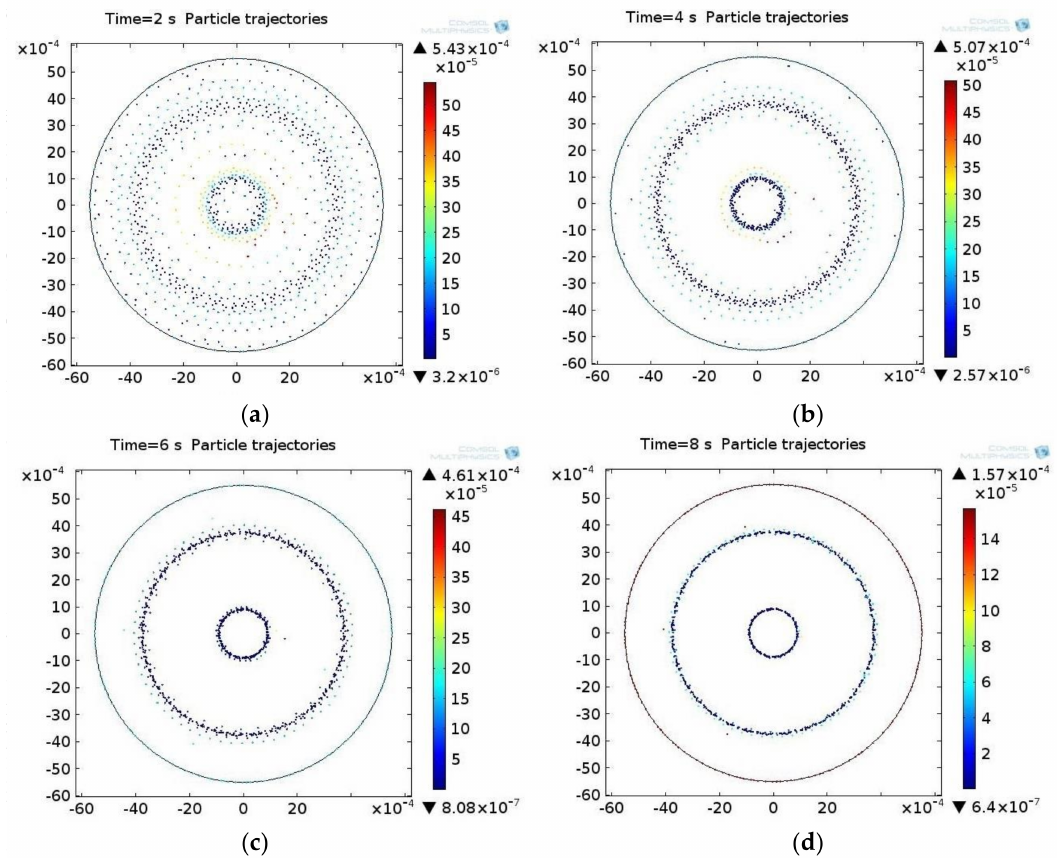
Figure 4. The distribution of particles in the acoustic pressure field in the biological suspension at different times t i : ( a ) 2 s, ( b ) 4 s, ( c ) 6 s, ( d ) 8 s.